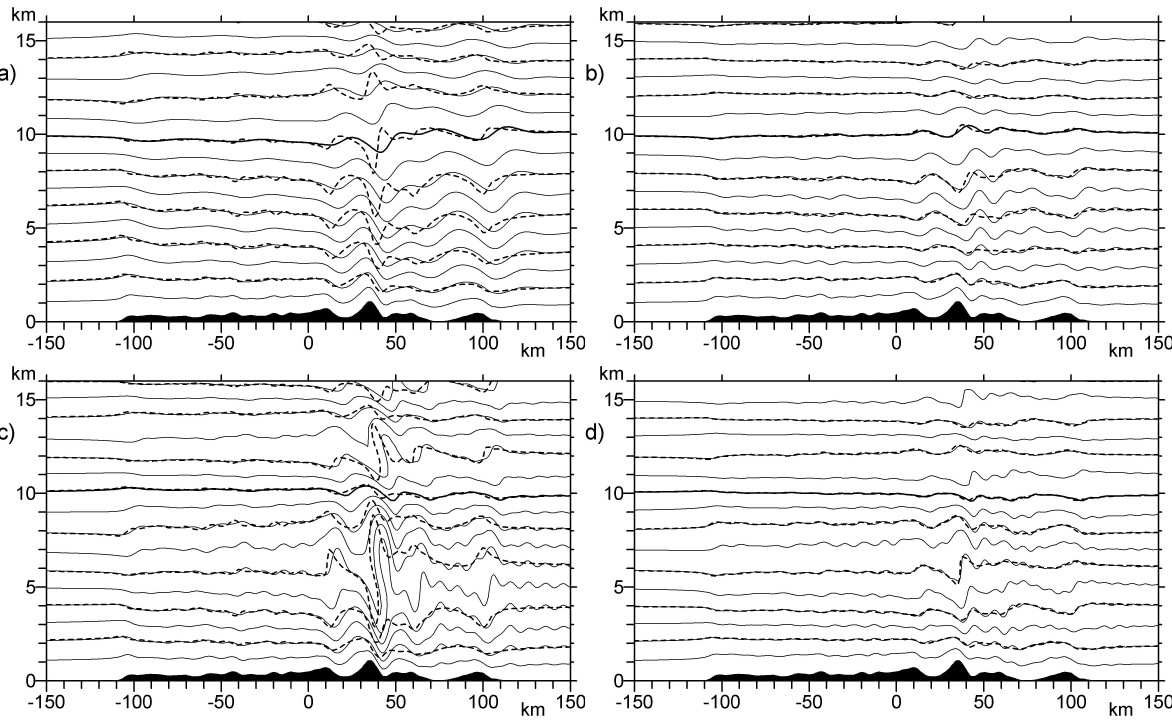
Fig. 5. Streamlines for hydrostatic solution, Eqs. (29, 30) (dashed), over the Ural Mountains, compared with non-hydrostatic solution, Eqs. (14, 15) (solid). The flow fields (a–d) correspond to the points A–D in Fig. 3a. The bold solid line denotes an internal dividing surface (tropopause). The individual streamlines for non-hydrostatic and hydrostatic solutions are given with 1-km and 2-km increments in their undisturbed height, correspondingly. Flow is directed from left to